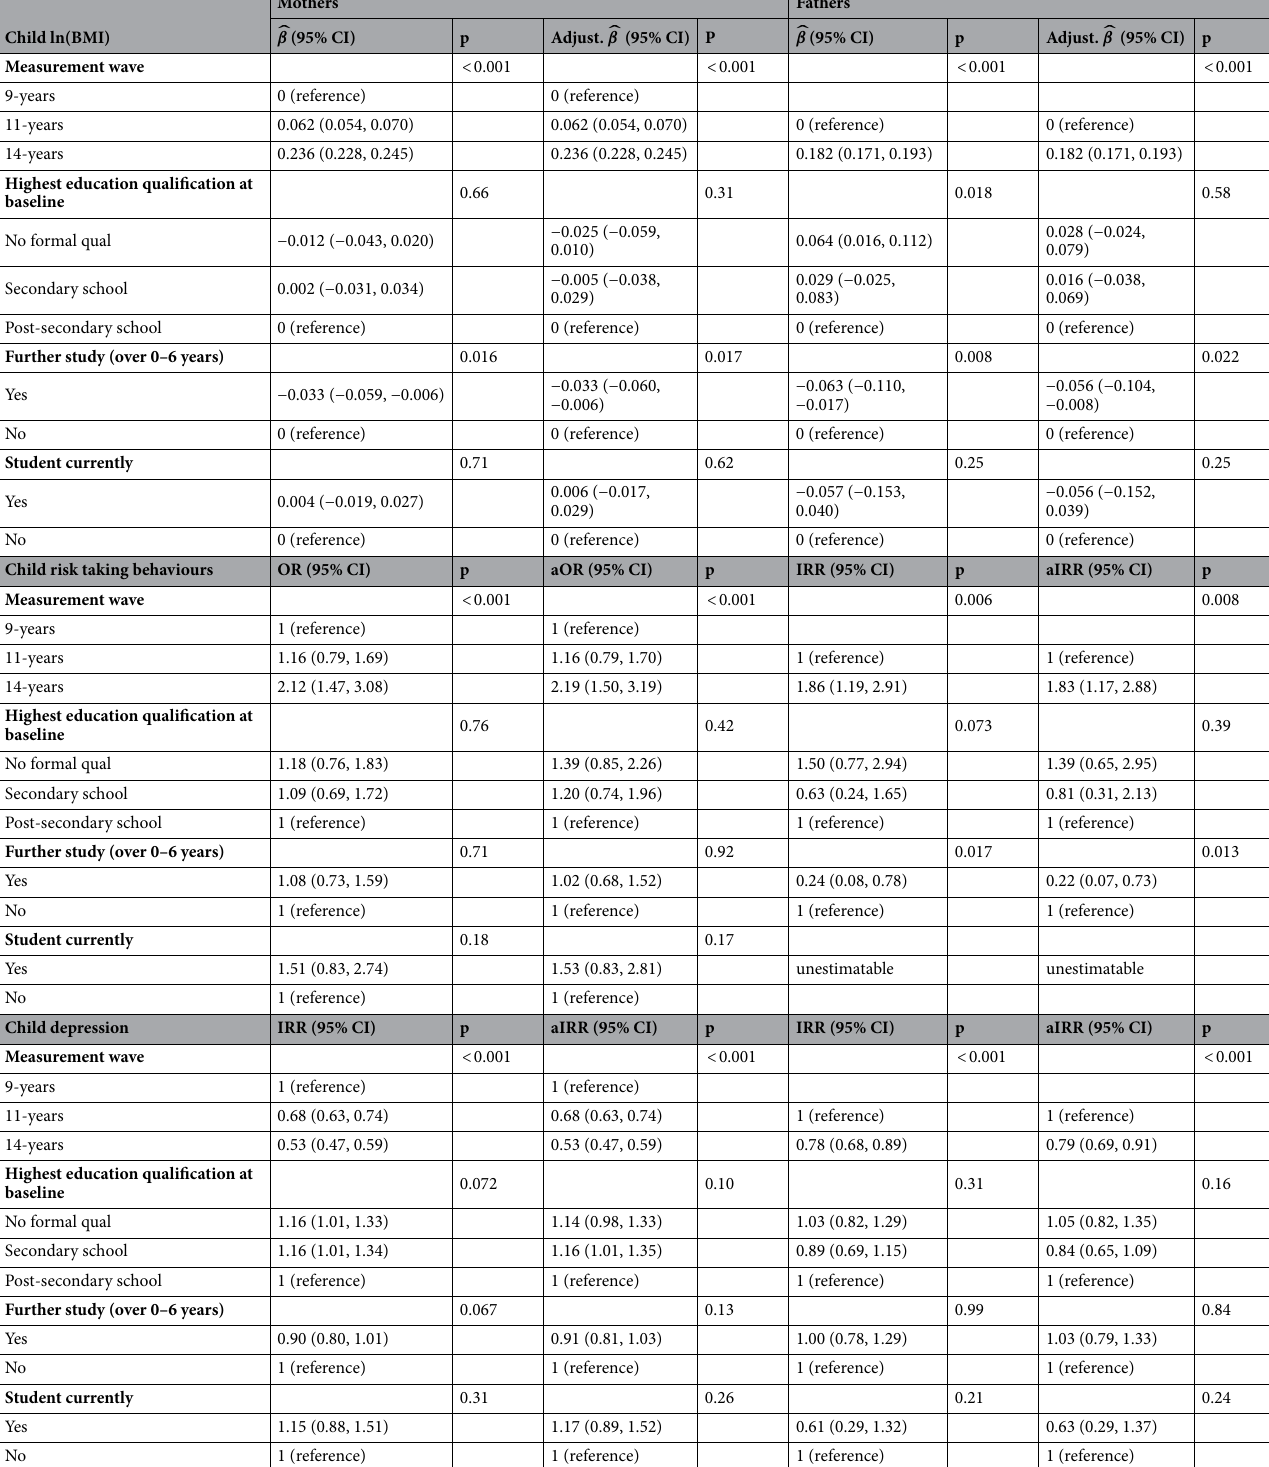
Table 3. Crude and adjusted GEE regression estimates and associated 95% CIs for child outcomes at measurement waves 9-years, 11-years, and 14-years. Crude estimates controlled for measurement wave, highest education qualification at baseline, further study (over 0–6 years), and student currently variables; adjusted estimates controlled for measurement wave, highest education qualification at baseline,